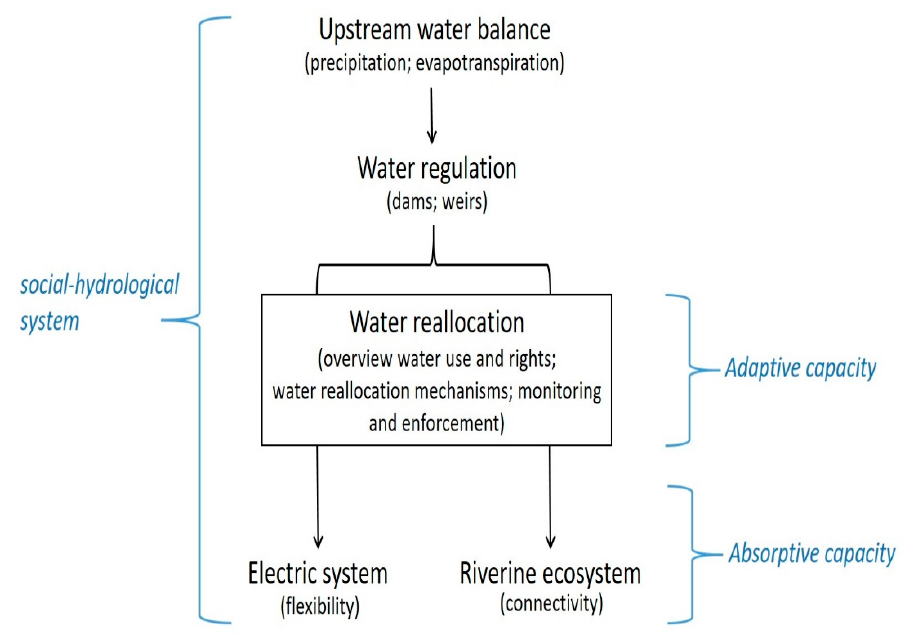
Figure 1. A framework of water reallocation and resilience in highly modified rivers.